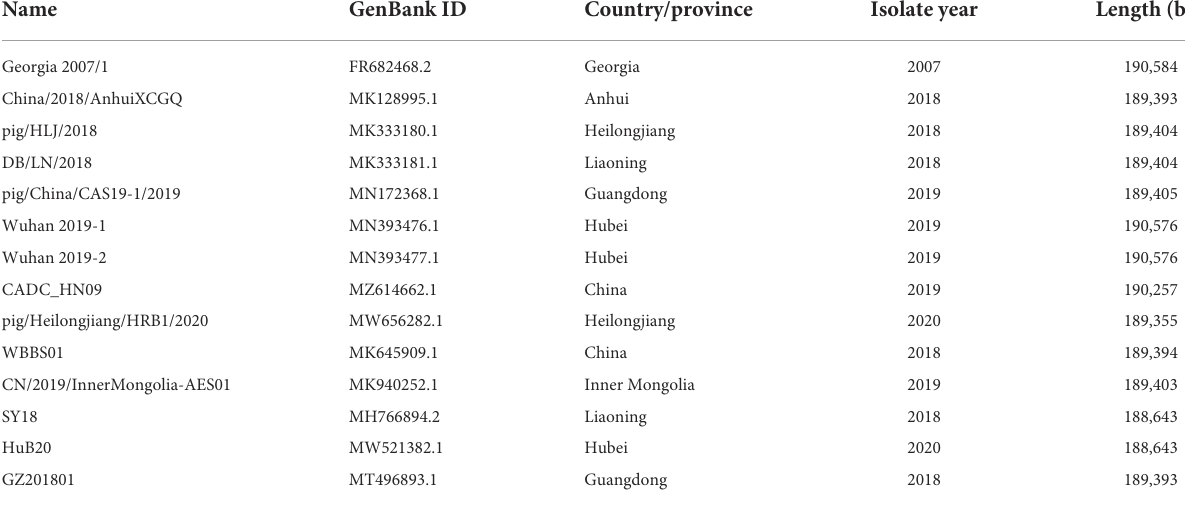
TABLE 1 Reference strains selected in this